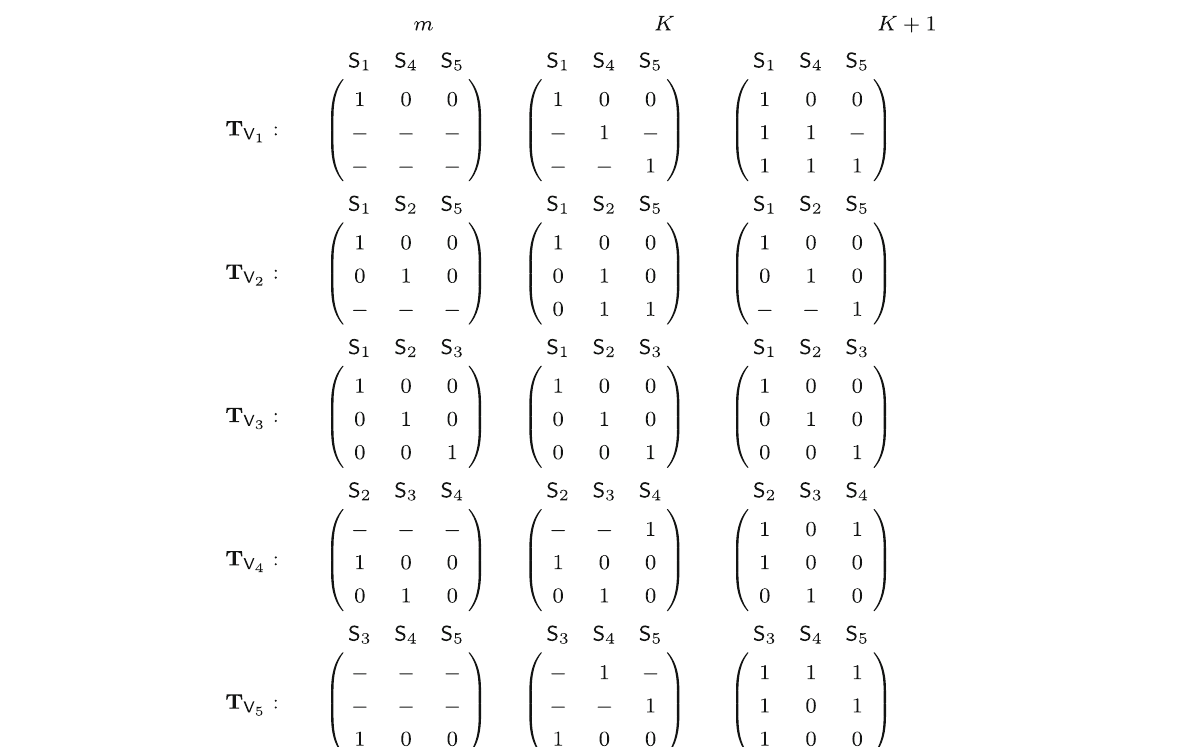
Fig.14 Theevolutionoftherelays’transmitmatricesattheendofsteps m , K ,and K + 1.Forthisexample,theloopinstep K +